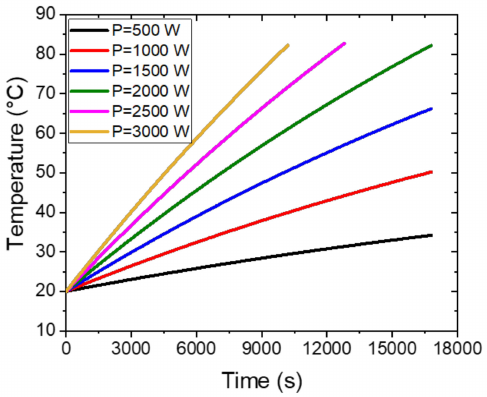
Figure 2. Temporal variation of water temperature for different heat inputs.